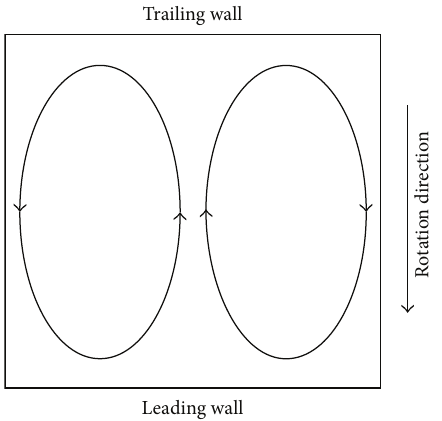
Figure 13: Experimental apparatus for a rotating channel of Car- done et al.